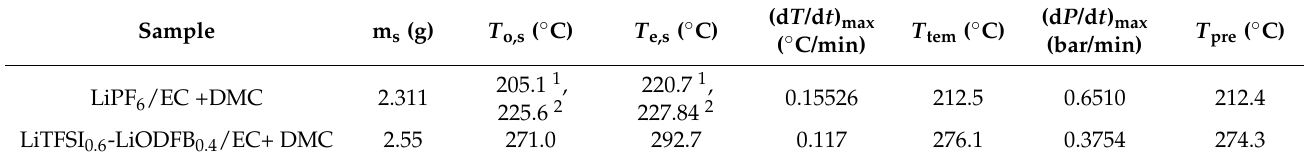
Table 3. Characteristic parameters of electrolyte samples in the ARC experiment.